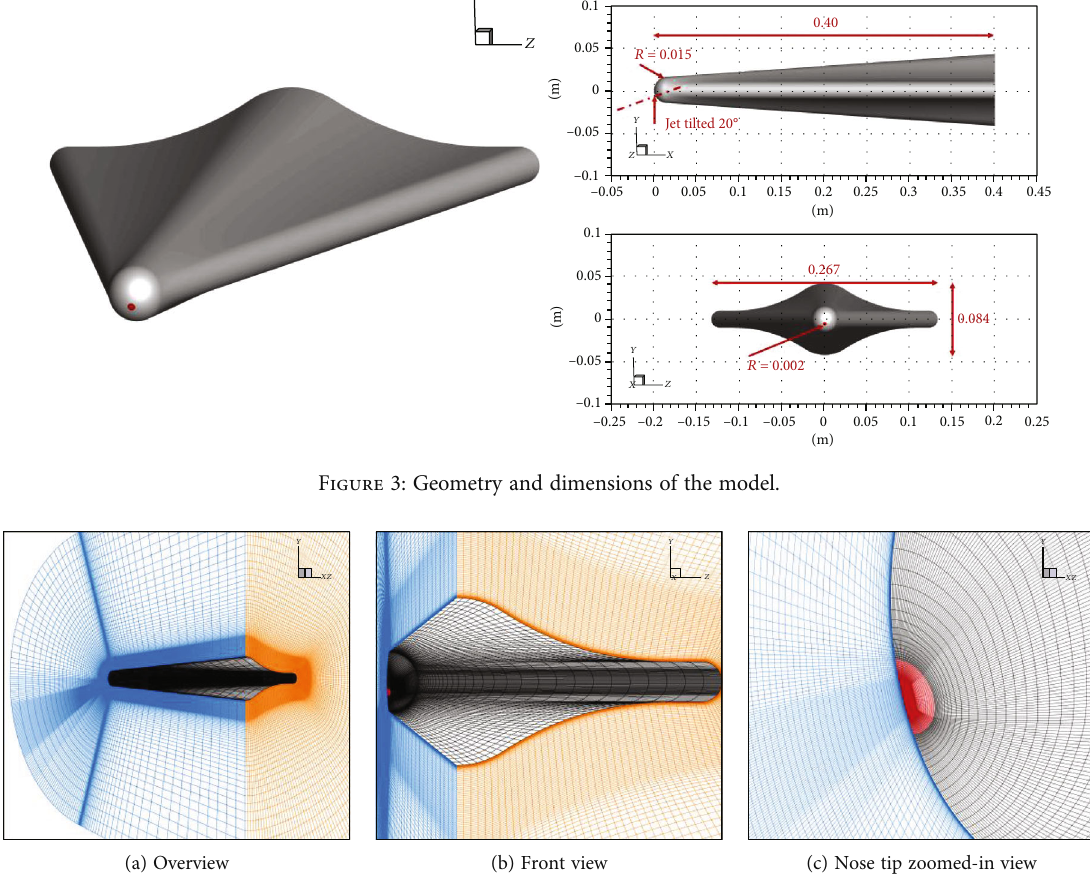
Figure 4: Computational grid (blue: symmetry plane; black: wall; orange: outlet; red: jet